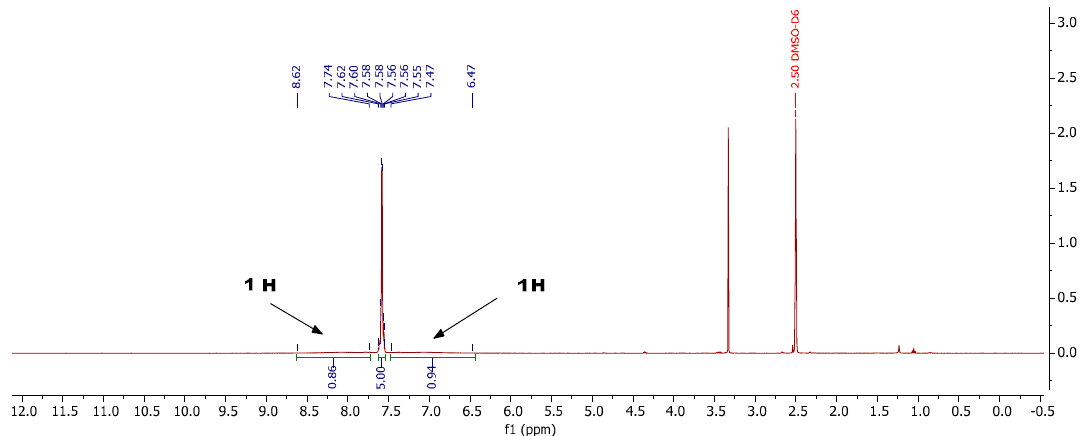
Figure 2. 1 H-NMR spectra of compound 4a in DMSO- d 6 recorded at 23 °C.